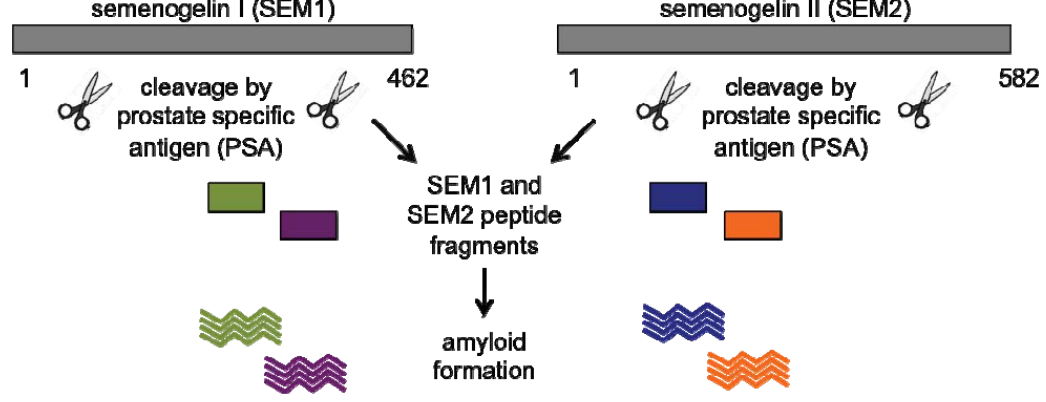
Figure 6. Proteolytic cleavage of semenogelin 1 (SEM1) and semenogelin 2 (SEM2). Full-length SEM1 and SEM2, the major components of the semen coagulum, are proteolytically cleaved by prostate specific antigen (PSA) to yield several peptide fragments. These peptide products readily aggregate and assemble into amyloid fibrils in seminal